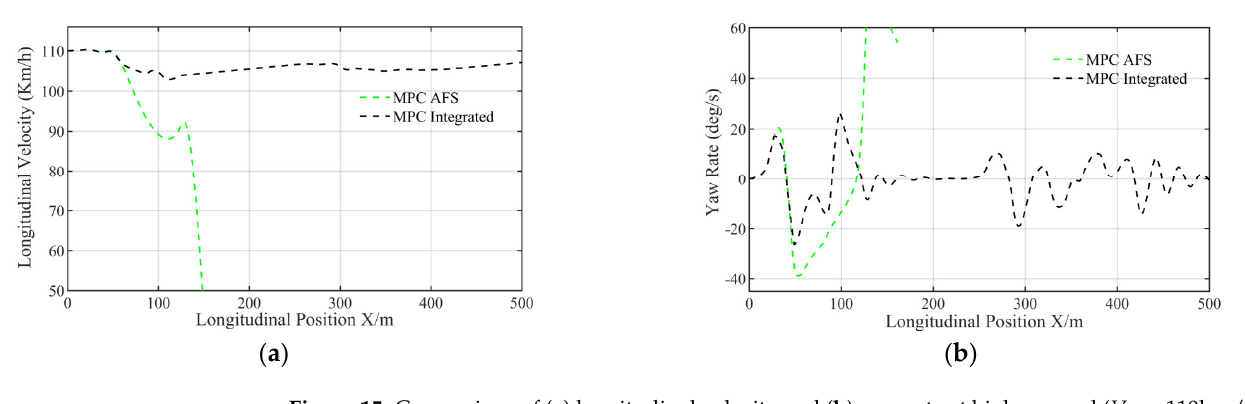
Figure 14. Comparison of ( a ) heading angle and ( b ) front wheel angle at higher speed ( V x = 110km/h).